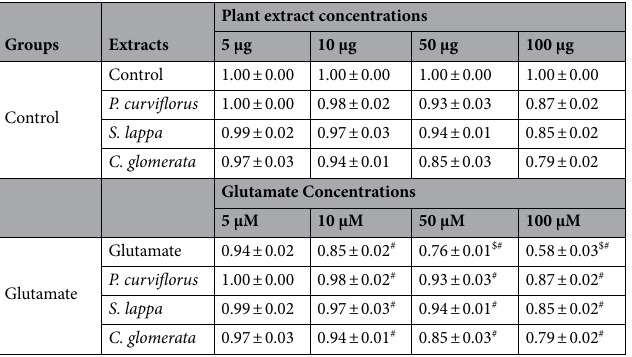
Table 3. Comparison with control cells (viability); glutamate-treated cells (viability). Comparison among all groups using Kruskal–Wallis test and using Mann–Whitney test to compare treated cells with controls (Non- parametric data). Comparison among all groups using One-Way ANOVA test with Multiple Comparisons (Dunnett test) to compare treated cells with glutamate-induced cells (Parametric data). $ p < 0.001, value between each group and the control group. # p < 0.001 value between all